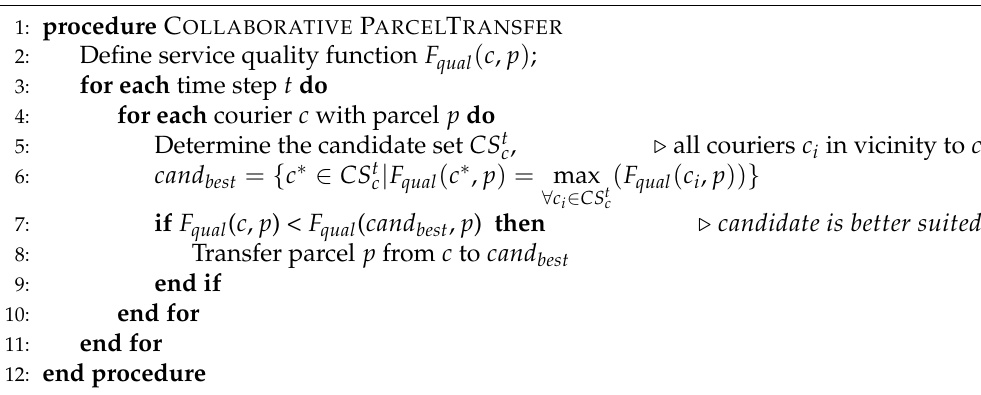
Algorithm 1 : Collaborative parcel transfer algorithm.